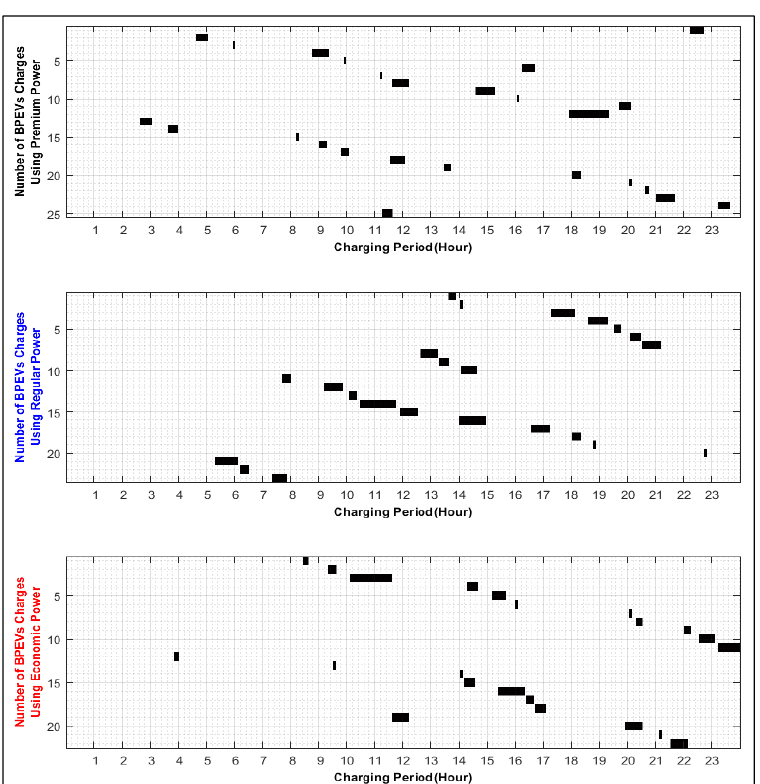
Figure 13. Daily demand per each charging power in an FCS.